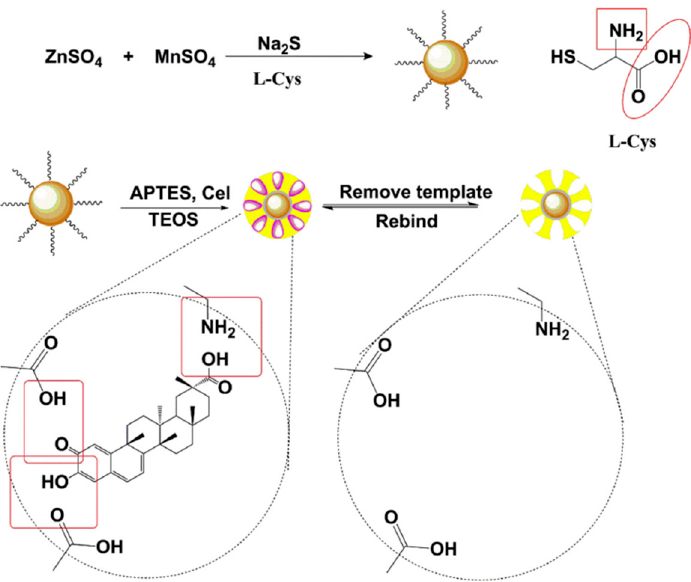
Figure 5. Schematic illustration of preparation procedure of MIPs@L-Cys@Mn-ZnS QDs [63].